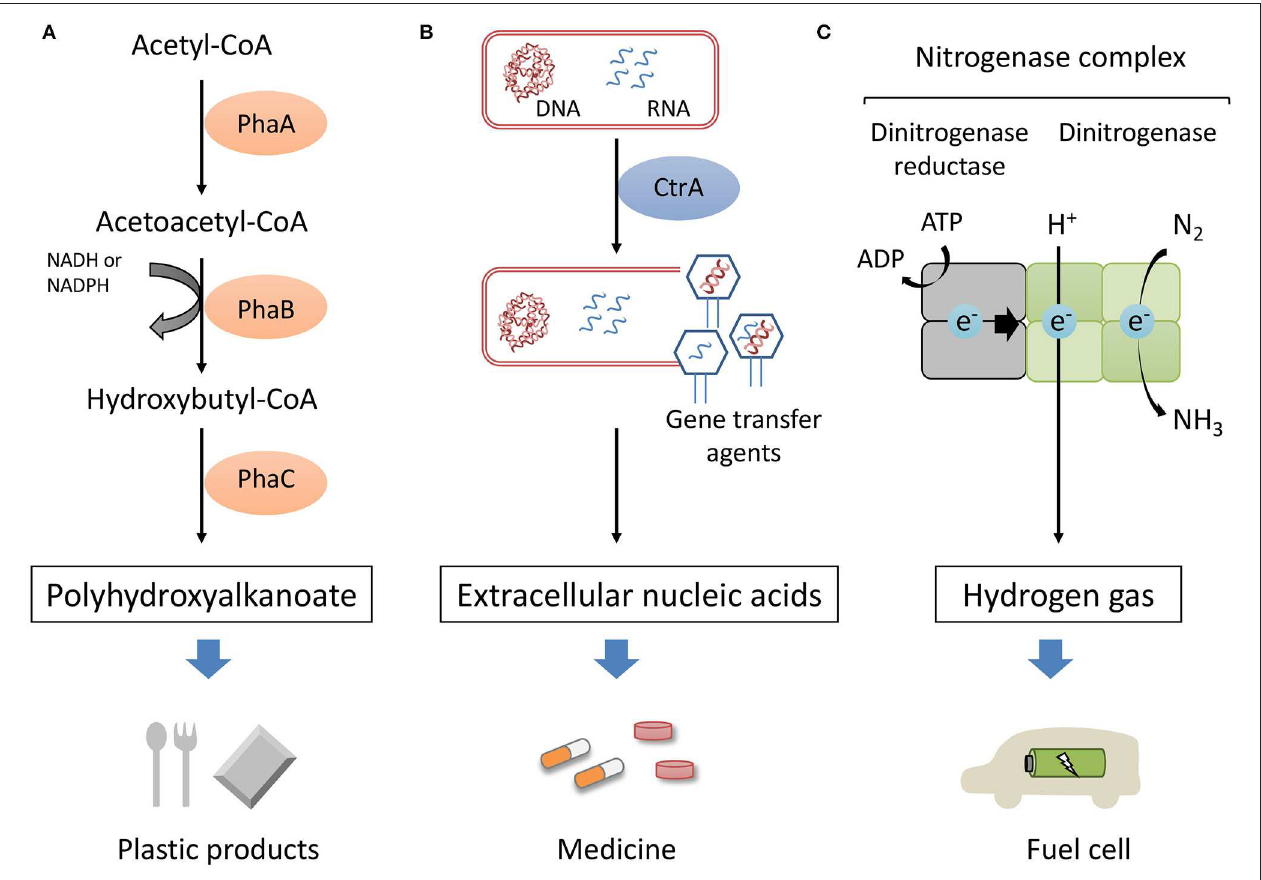
FIGURE 1 | Sustainable production of high-value compounds in marine purple photosynthetic bacteria. PHA was produced from acetyl-CoA in tree steps (A) . Extracellular nucleic acids were produced in the process of GTA-like particle production controlled by CtrA (B) . The nitrogenase complex is composed of dinitrogenase reductase and dinitrogenase. Nitrogenase catalyzes the proton reduction to hydrogen as well as the reduction of nitrogen to ammonia (C) .